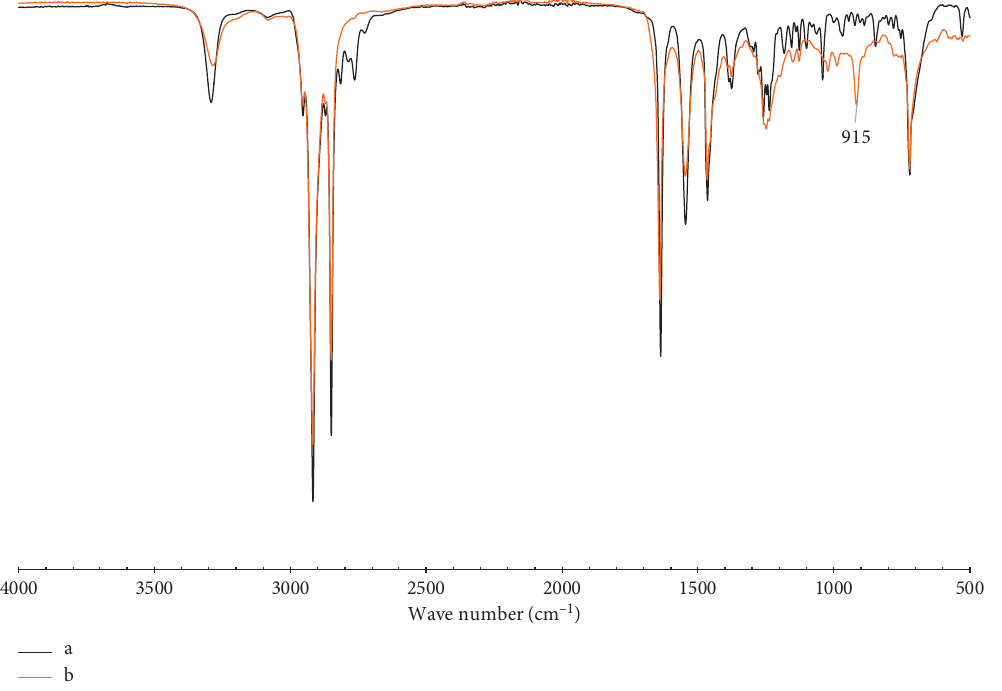
Figure 1: FT-IR spectrum of the amine and amine-oxide.